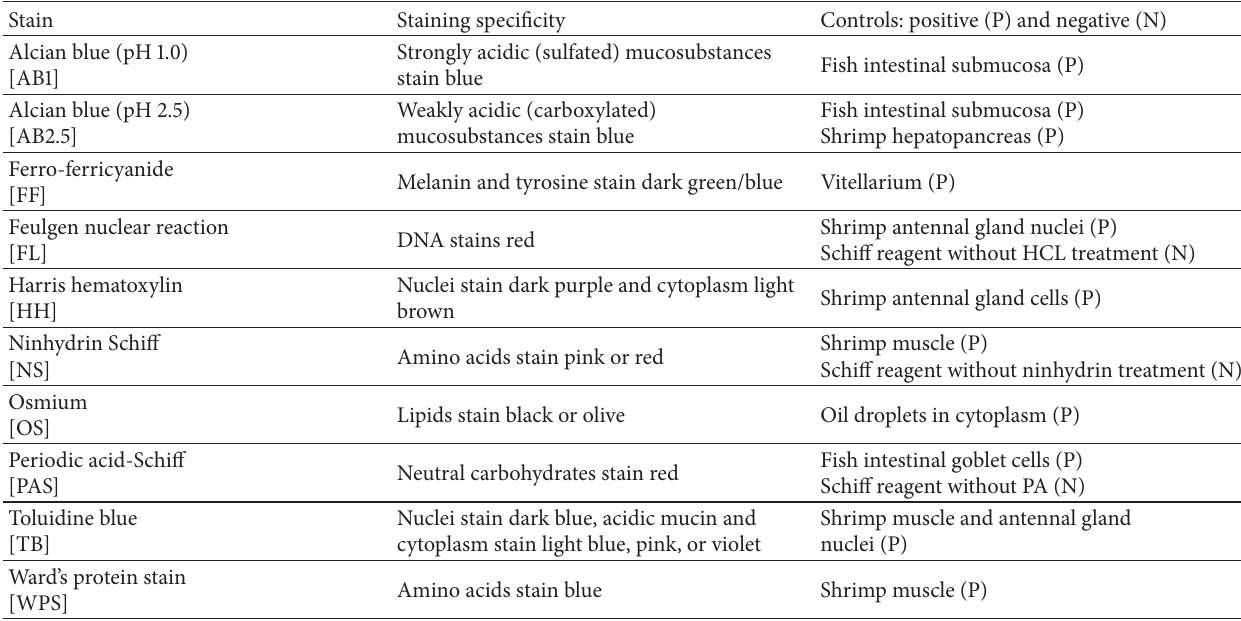
Table 1: Stains and staining